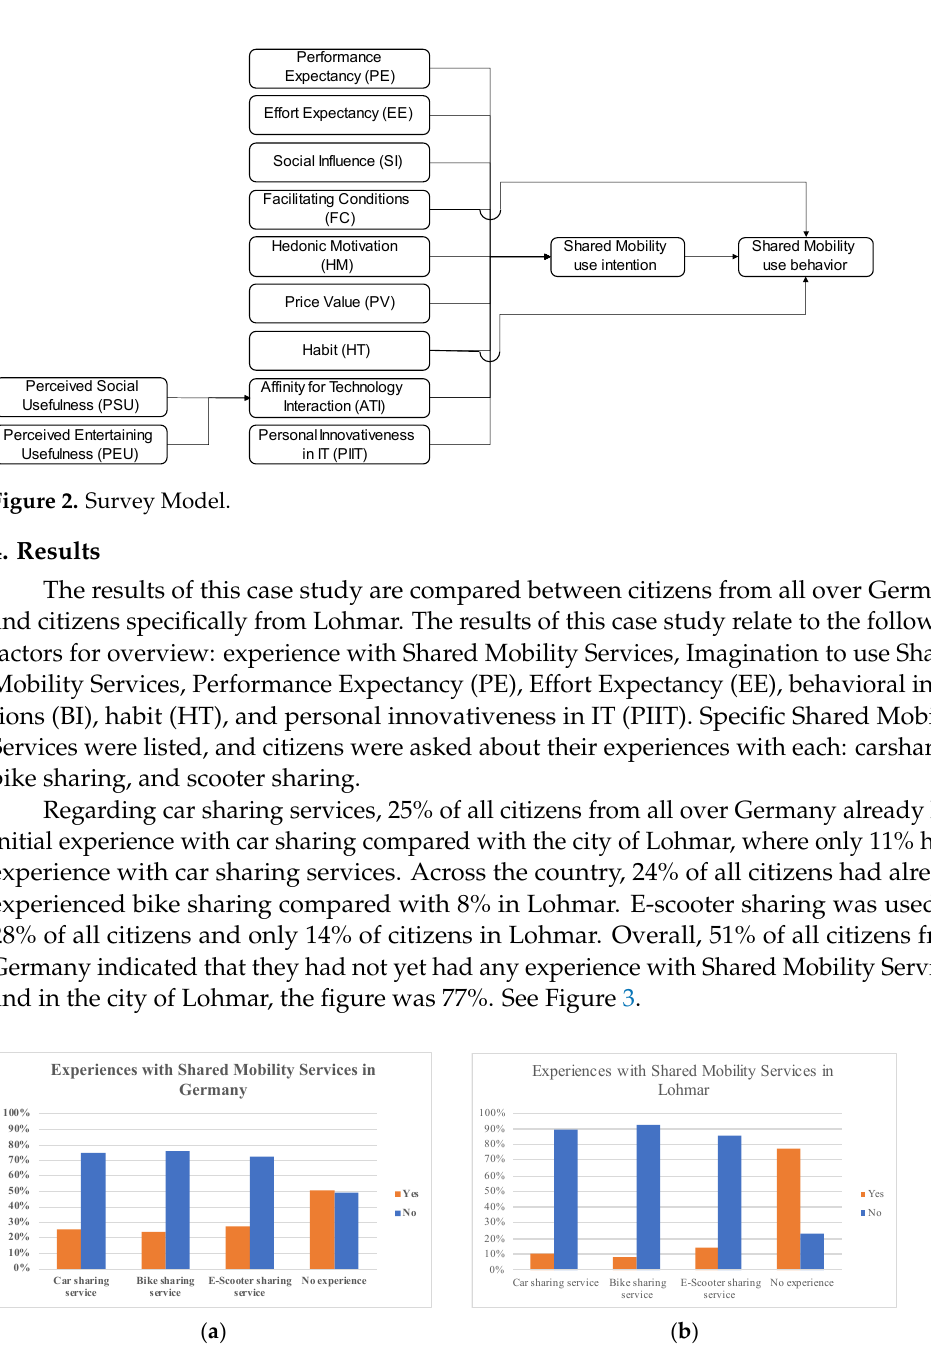
( b ) Figure 4. Imagination to use SMS: ( a ) Germany vs. ( b ) Lohmar. In terms of Performance Expectancy (PE), 43% of all citizens across Germany indi- cated that they find Shared Mobility Services useful. In the city of Lohmar, 34% of citizens find Shared Mobility Services useful in their daily lives, and 37% of all citizens said that Shared Mobility Services increased their chances of reaching places that are important to them; in Lohmar, 27% agreed with this statement. Of all citizens, 33% said that using Shared Mobility Services helped them get things done faster, and in Lohmar, 21% agreed with this statement. That the use of Shared Mobility Services increases productivity was stated by 18% of all citizens, and in Lohmar, 12% agreed with this statement. See Figure 5.